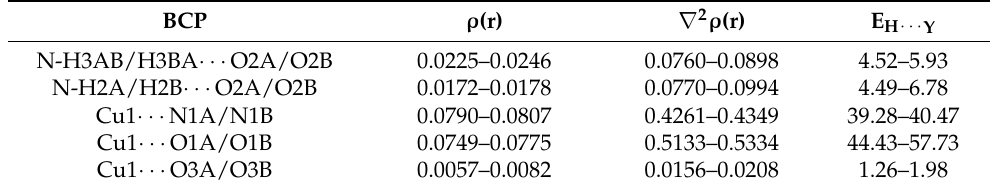
Table 8. Topological parameters (in a.u.) and interaction energies E H ··· Y (in kcal mol − 1 ) of compound [Cu(Citr) 2 ] n . Atom labels correspond to those shown in Figure